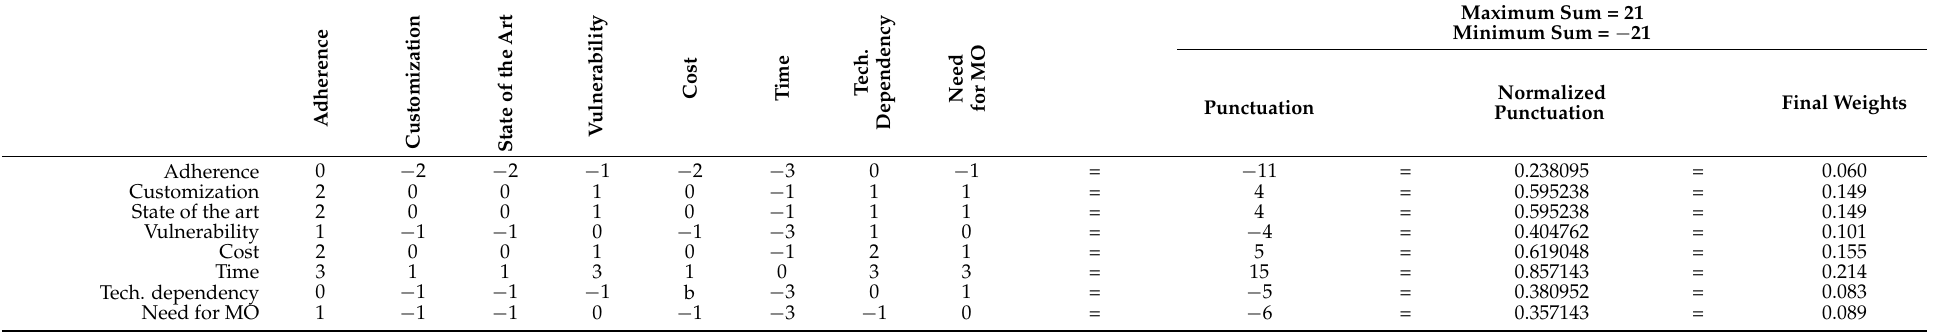
Table 4. Calculation of weights in the criteria in